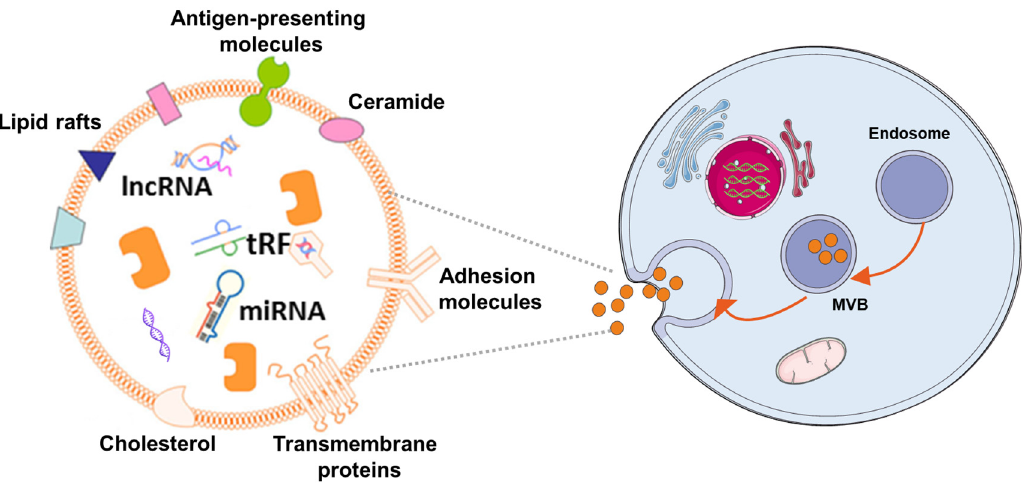
Figure 1. The mechanism of EV biogenes. Exosomes are released by cells of hematopoietic and non-hematopoietic origin. The EV production process can be summarized as follows: (1) the cytoplasmic membrane inward budding forms intracellular vesicles, which are termed as endosomes; (2) intracellular vesicles further develop to form multivesicular bodies (MVBs); (3) MVBs fuse with the cytoplasmic membrane to release exosomes, which can be incorporated into recipient cells through pinocytosis/phagocytosis or influence recipient cell signaling via ligand-receptor interaction.